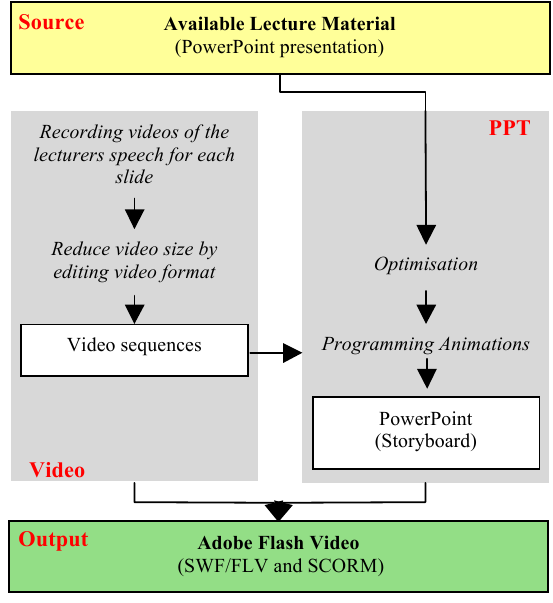
Figure 2: Flowchart of creating Lectures-on-Demand